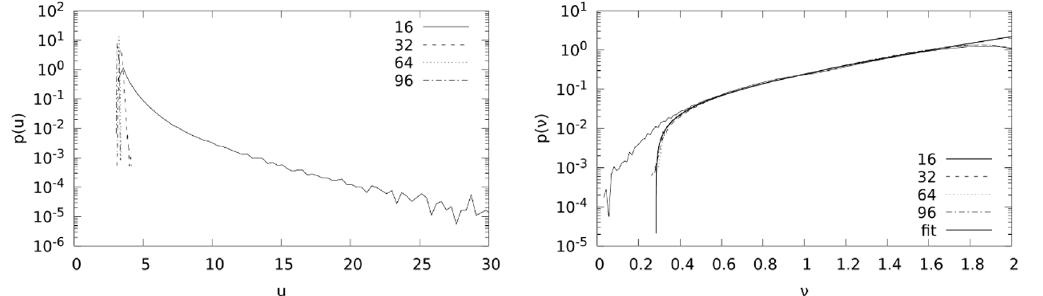
Figure 5 . (Left) The distribution p ( u ) of u de(cid:12)ned in eq. (3.9) for m (cid:22) = (0 : 5 ; 0 : 5 ; 1 ; 2 ; 4 ; 8 ; 8 ; 8 ; 8 ; 8), m f = 0 : 9, (cid:15) = 0 : 16. For N = 16 we observe a long subexponential tail indicating the presence of the singular-drift problem. For N (cid:21) 32, where the singular-drift problem is absent, the tail falls o(cid:11) (super)exponentially. (Right) The small (cid:23) k distribution of the Youla decomposition values (cid:23) k (cid:21) 0, k = 1 ; : : : ; n , n = 8( N 2 (cid:0) 1) of the antisymmetric matrix M for the same parameters, together with a (cid:12)t of the form ( (cid:23) (cid:0) (cid:23) c ) a e b(cid:23) with (cid:23) c = 0 : 283(1), a = 0 : 82(2) and b = 1 : 49(3). The cuto(cid:11) (cid:23) c develops for N (cid:21) 32, whereas for N = 16 the values accumulate near zero, causing the singular-drift